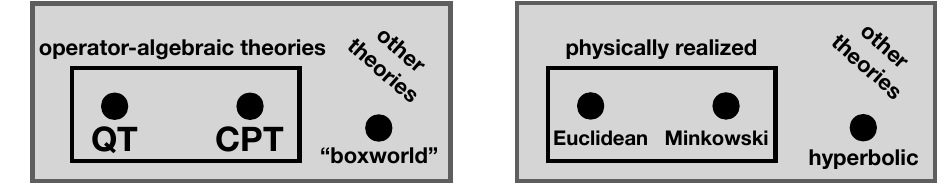
Figure 1: Left: the “landscape” of probabilistic theories. QT is for quantum theory and CPT for classical probability theory (as defined later). Right: as a suggestive analogy (see main text), the “landscape of theories of (spacetime)